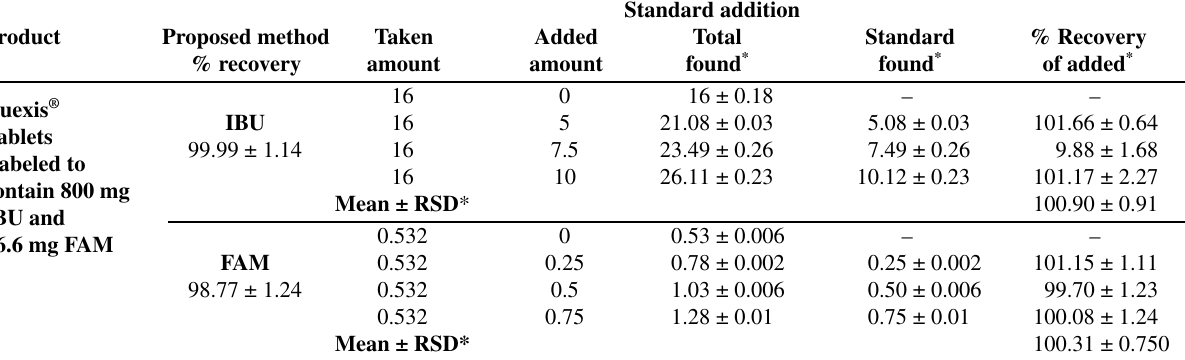
Table 2: Analysis of IBU and FAM in marketed formulations by TLC-densitometric method and application of standard addition